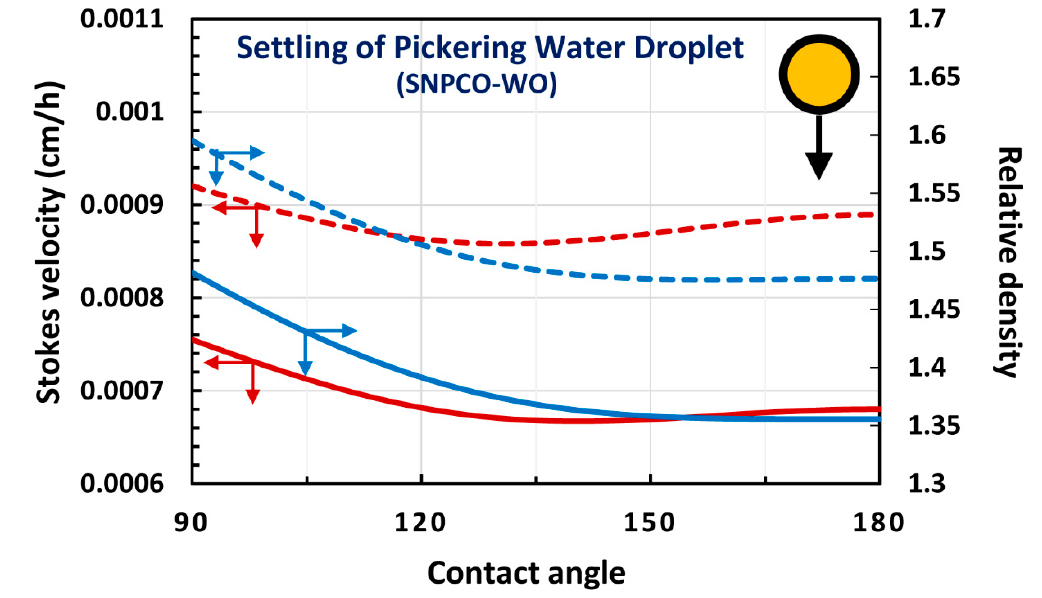
Figure 17. Variations of Stokes settling velocity and relative density of a single Pickering water droplet with contact angle (SNPCO-WO Pickering emulsion). The solid curves represent square packing and the dashed curves represent hexagonal packing of nanoparticles at the oil-water interface.